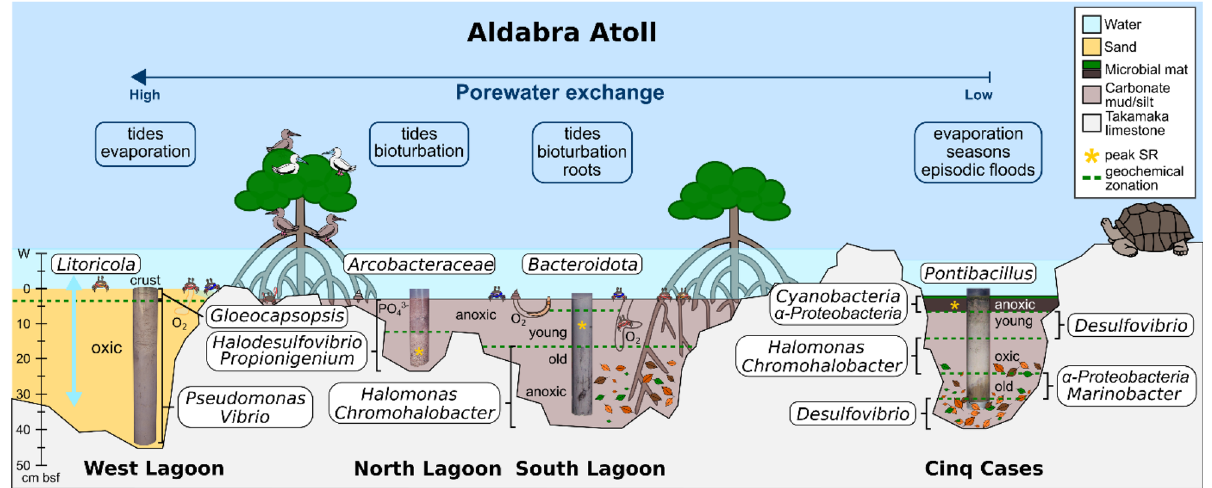
Figure 6. Model of Aldabra’s sediment environments, detected bacterial key taxa and geochemical zones. The sampling sites are ordered by sediment dynamic from left to right, starting with the highest. Most abundant bacterial taxa at each site are indicated close to the respective sediment core. Pictograms indicate further factors, such as macrofaunal input, bioturbation and mangrove roots and